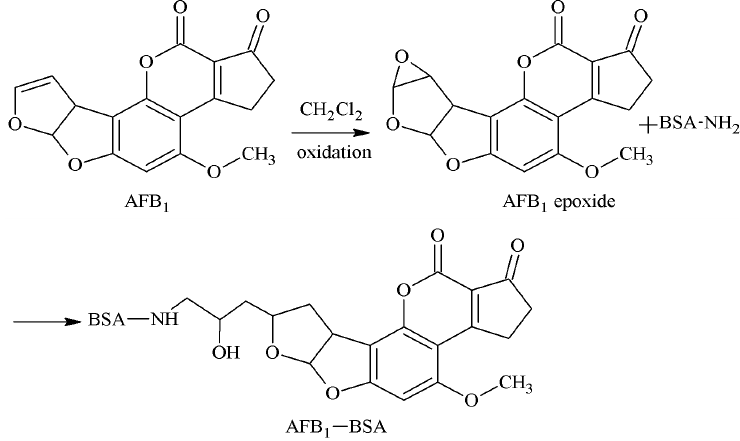
Figure 6. Synthesis of the AFB1-BSA antigen by the epoxide (EP) method.